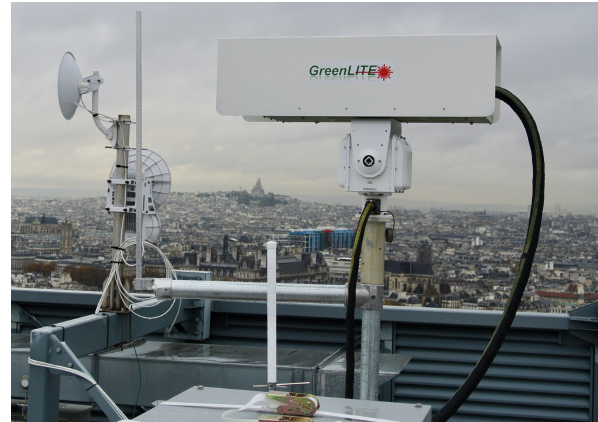
Figure 2. Image of a GreenLITE ™ transceiver atop the Jussieu tower. The pair of transceivers were deployed in Paris, France, from November 2015 through November